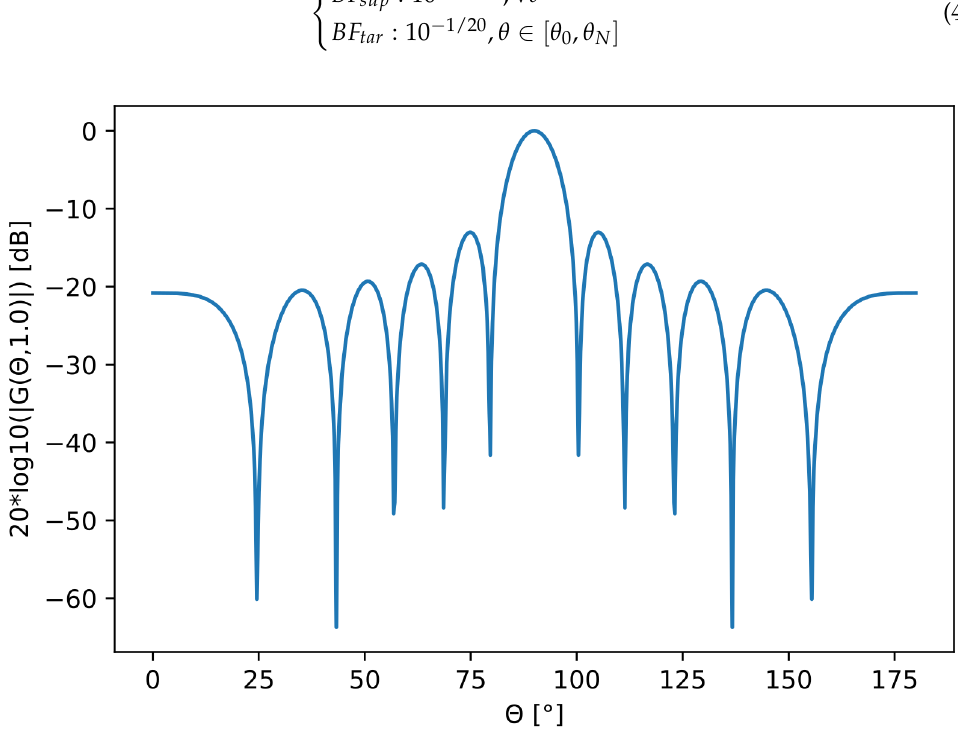
Figure 1. Beampattern (blue line) for the 11-element linear phased